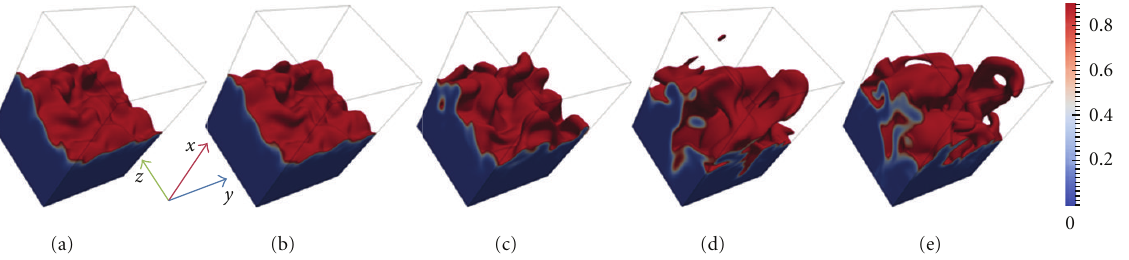
Figure 1: Instantaneous isosurfaces of c ranging from 0.01 to 0.99 at t = 1 . 0 δ th /S L for cases (a)–(e) A–E.